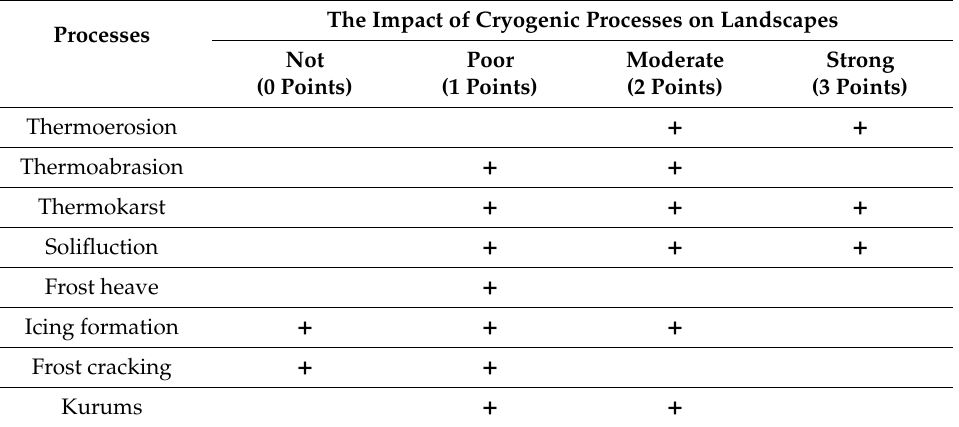
Table 3. The impact of cryogenic processes on landscapes.